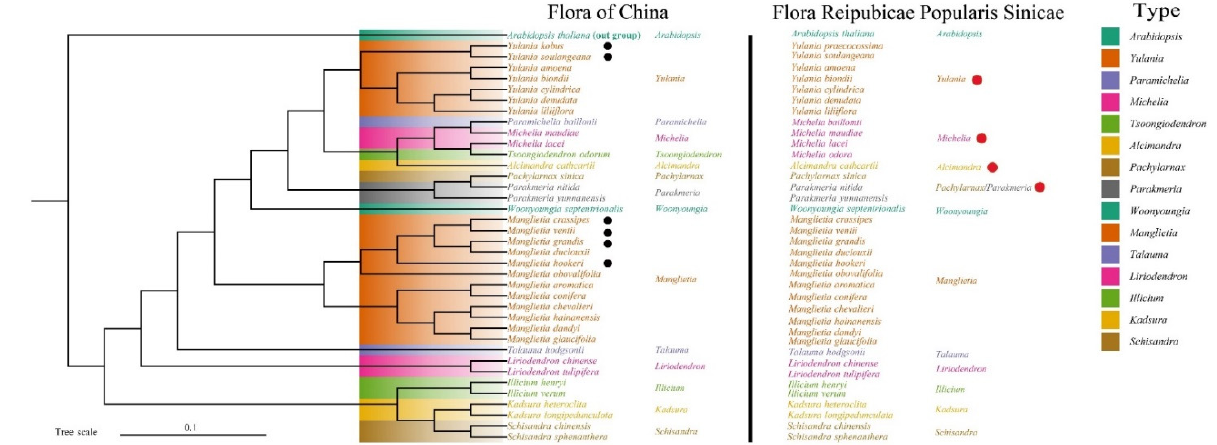
Figure 6. Maximum likelihood (ML) phylogenetic tree based on 37 complete chloroplast genomes of Magnoliaceae. Note: Black circles indicate the six species of Magnoliaceae in this study. The red circles indicate the genera whose phylogenetic positions were discussed in this